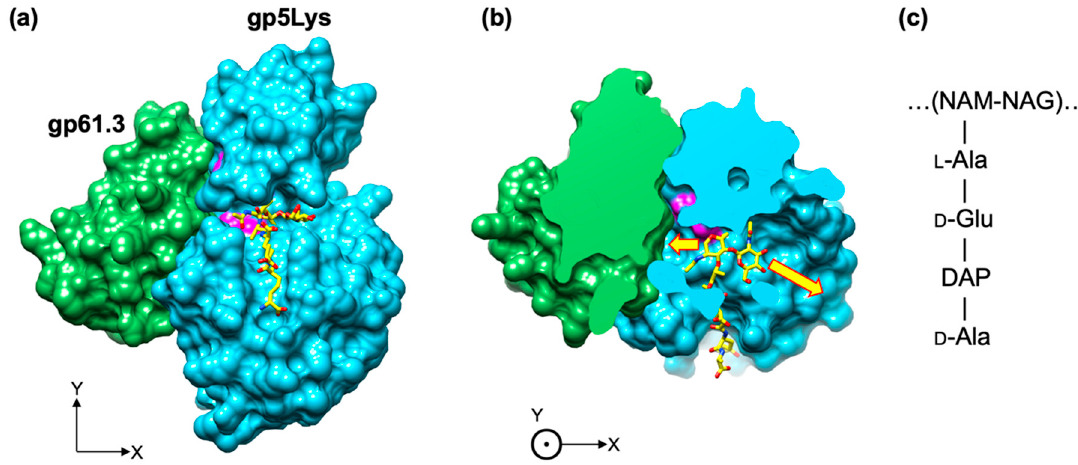
Figure 11. Gp61.3 interferes with free access of the polysaccharide moiety of the peptidoglycan substrate to the gp5Lys active site cleft. ( a ) and ( b ): two orthogonal views of the gp61.3-gp5Lys complex in the molecular surface representation. One repeating unit of the peptidoglycan is shown as a ball-and-stick model with C atoms in yellow, N in blue, and O in red. The active site residues of gp5 (Glu184, Aps193, Thr199) are colored magenta. In panel ( b ), the front part of the model is removed (slabbed away) to reveal the substrate-binding cleft. The yellow arrows indicate the directions in which the polysaccharide moiety of the peptidoglycan extends away from the presented model. ( c ) The chemical structure of the repeating unit of the peptidoglycan, the substrate of gp5. The continuation of the sugar moiety is shown with ellipses. NAM, NAG and DAP stand for N-acetylmuramic acid, N-acetylglucosamine and meso-diaminopimelic acid, respectively.